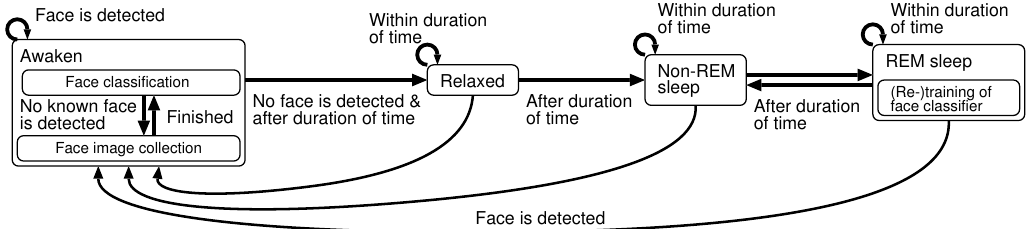
Figure 3. Finite state machine of